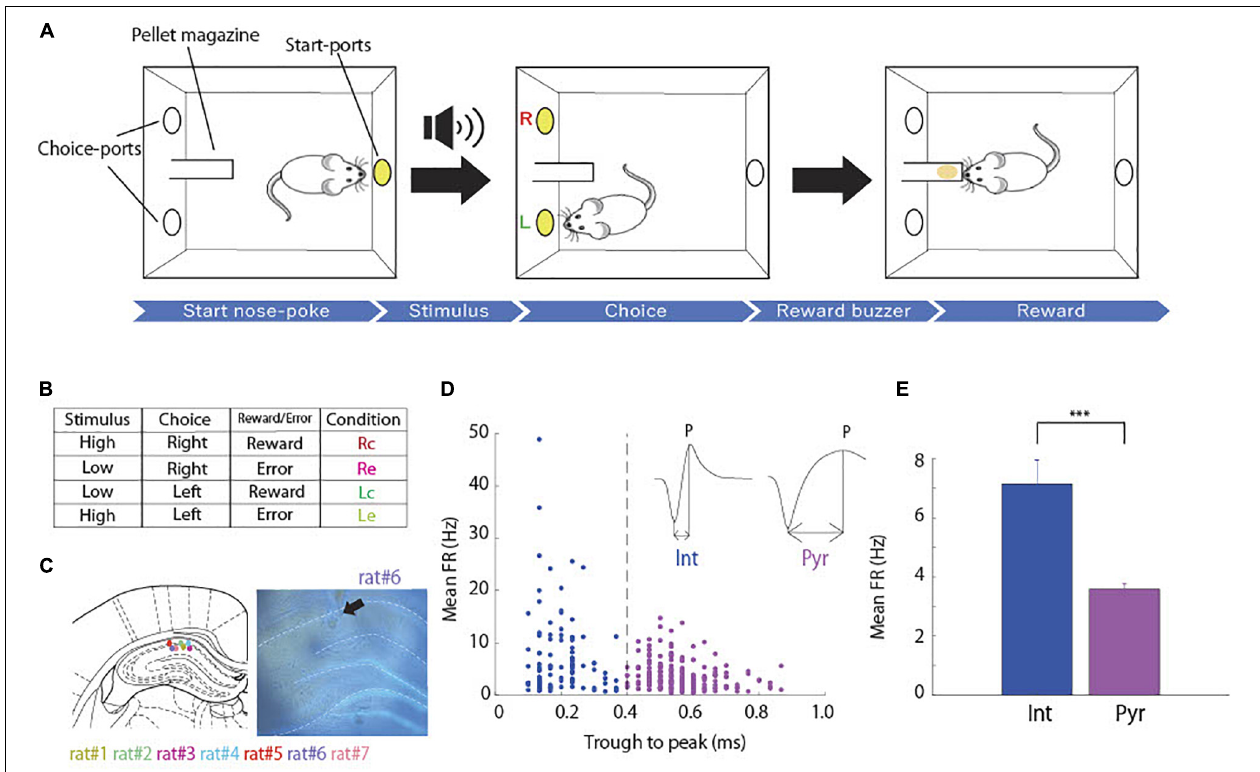
FIGURE 1 | Associative memory task and cell classification. (A) Schematic representation of the task. (B) Table of task conditions, combinations of stimuli, choices and outcomes, and their abbreviations. (C) The coronal section indicating recording sites in hippocampal CA1 (arrow). Each color dots corresponds to the animal identification number. Modified from Paxinos and Watson (2007). (D) Classification of putative interneurons (Int, blue) and putative pyramidal neurons (Pyr, magenta) according to spike width (dashed lines). Spike width was measured by subtracting the time at the troughs from that at the peak of each spike waveform (arrow lines). (E) Comparison of mean firing rates between putative pyramidal neurons ( n = 207) and interneurons ( n = 99; two-sample t -test; p = 1.51 × 10 − 8 ) *** p <